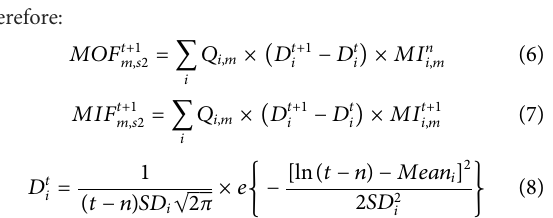
FIGURE 3 Samples and data distribution. (A) shows a vintage histogram for training samples in Shenzhen. (B) shows a few building footprints and vintage in the Longcheng community in Shenzhen as an